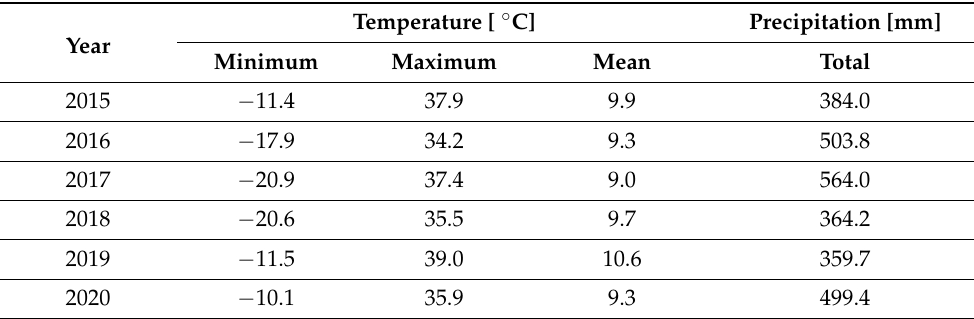
Table 6. Annual temperatures and precipitation at the Experimental Orchard in D ˛abrowice